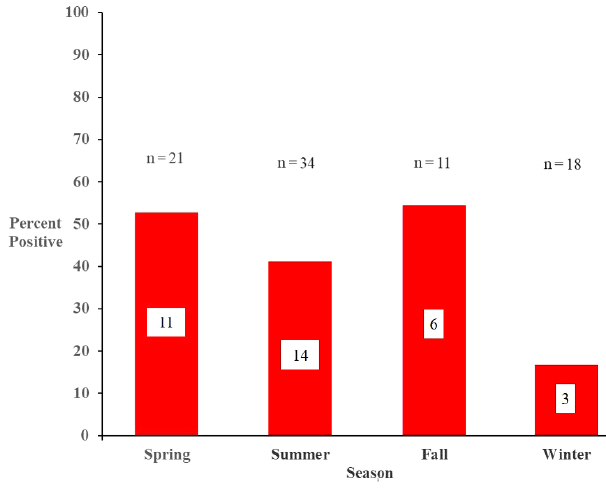
Fig. 3 . Percent of all Barred Owls ( Strix varia ) positive for exposure to anticoagulant rodenticides during each season collected from Humboldt and Del Norte Counties during the years of 2006–2013 in Northwestern California,